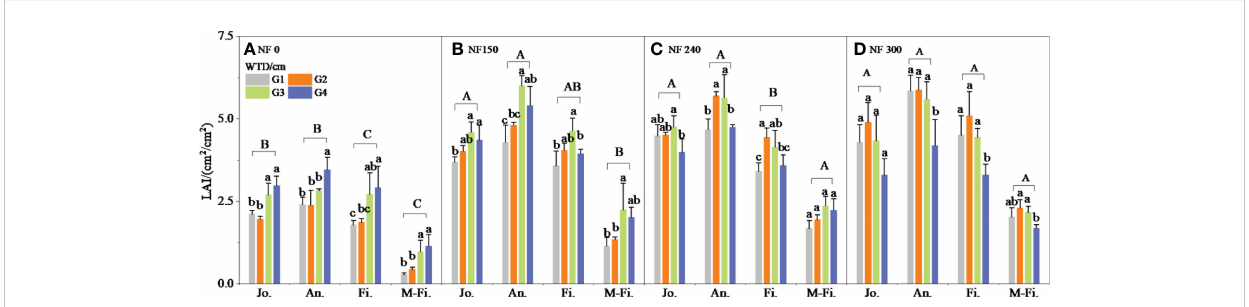
FIGURE 3 The LAI of winter wheat. M-Fi. means the middle fi lling stage, The same is true below. Different lowercase letters indicate signi fi cant differences between different WTD under the same N application (P < 0.05), and uppercase letters indicate signi fi cant differences between different N application treatments (P < 0.05).